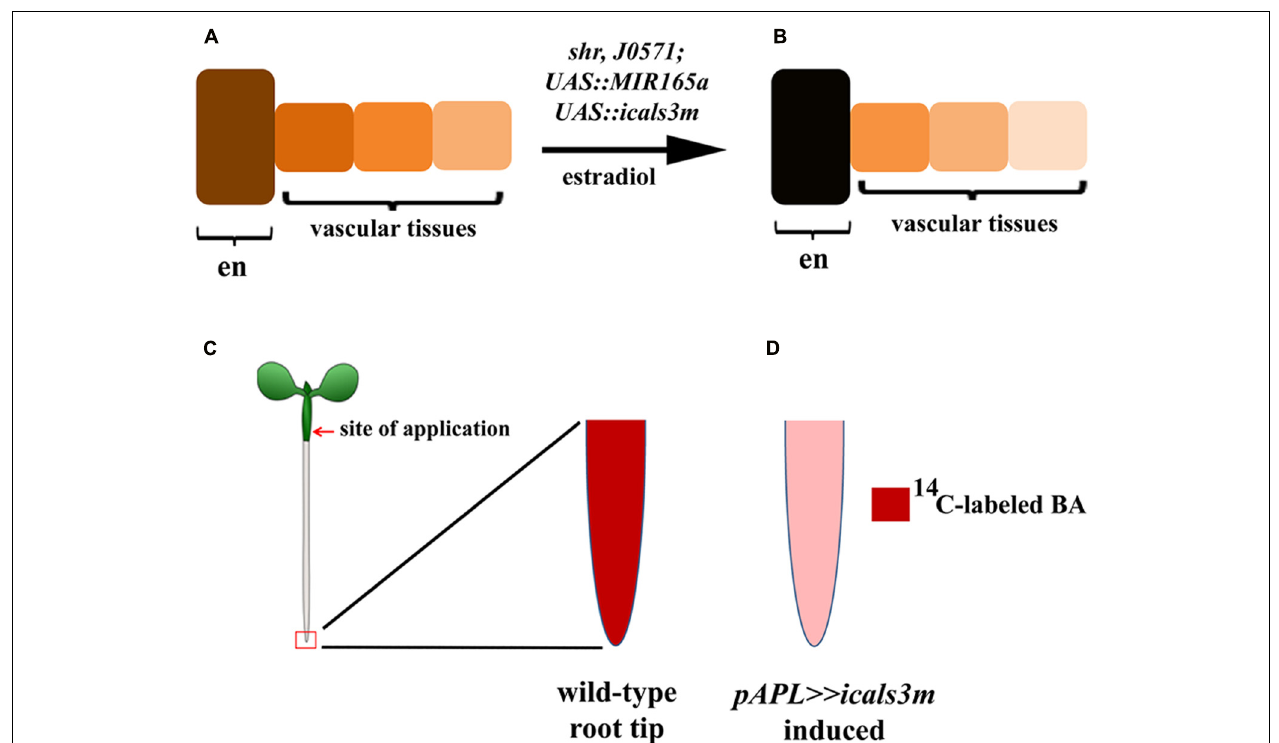
FIGURE 2 |Applications of the icals3m system in studying the route of miR165 and long-distance transport of cytokinins. (A,B) Schematic diagram illustrating the use of icals3m in inhibiting the movement of miR165 from the endodermis to the vascular tissues. Only endodermis (en) of GT is shown in the schematic figure. (A) Under non-inducible condition, the GT expressed miR165a can diffuse freely from endodermis to the vascular tissues and makes a concentration gradient.The cells directly connected to the endodermis have high levels of miRNAs whereas miRNA levels decrease in the cells that are away from the endodermis, as shown by color gradients. (B) Upon cals3m induction in the GT, the miRNAs are getting trapped inside the endodermis and their concentrations in the vascular tissues are reduced.